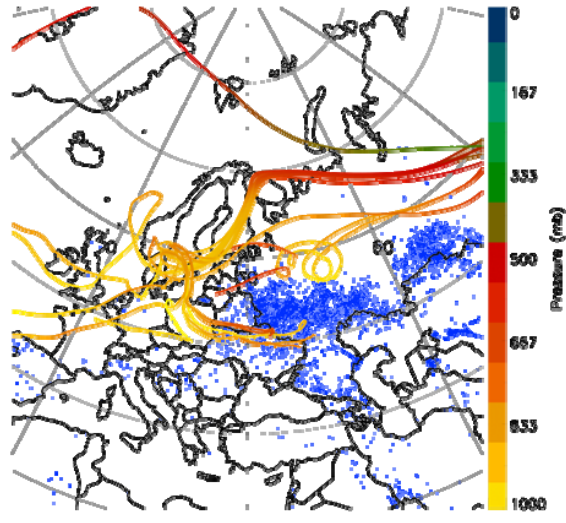
Fig. 16. Trajectories as in Fig. 15a plotted with FLAMBE data (blue dots) for the period 26 March - 6 April 2008.